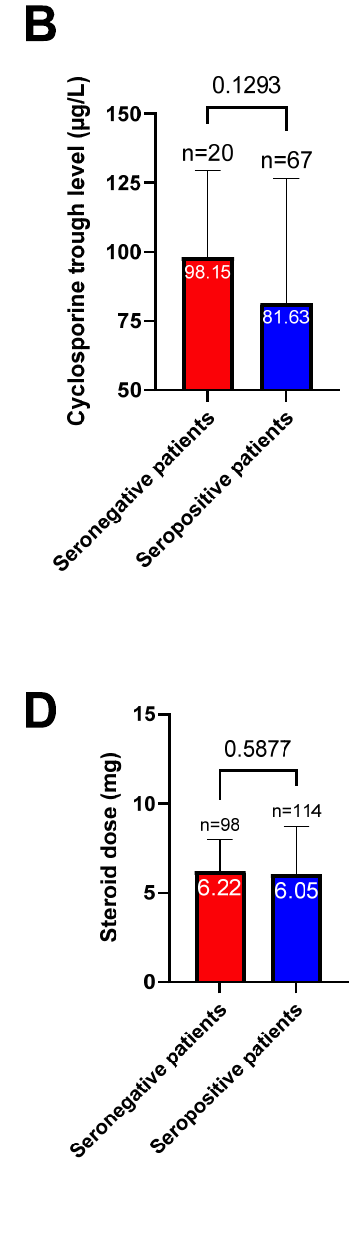
Figure 7. Mean tacrolimus trough level ( A ), Cyclosporine trough level ( B ), mycophenolate mofetil (MMF) dose ( C ), and steroids dose ( D ) according to the serological response after the third vaccine dose. Means are marked in white for each column; the number of patients and p values ( χ 2 test) are also reported.